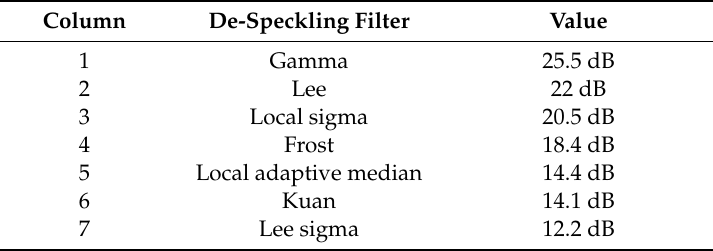
Figure 2. Reference SAR image and its PSD modeling ( a ) Reference SAR image; ( b ) PSD of reference SAR image; ( c ) PSD of reference SAR image in presence of little noise; ( d ) PSD of reference SAR image in noise-free medium; ( e ) PSD of high-frequency noise. Table 1. PSD modeling results after HMS